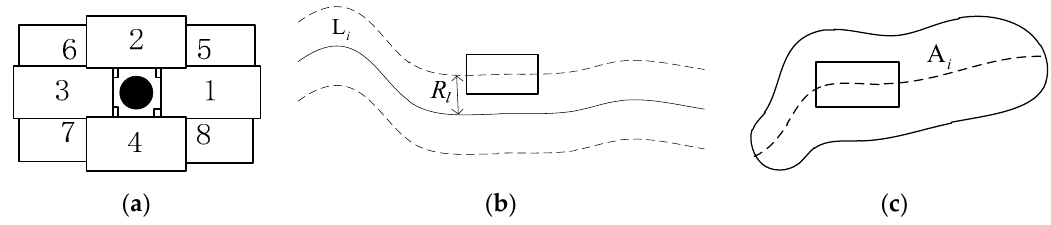
Figure 1. ( a ) A candidate-position model of a point feature; ( b ) a candidate-position model of a line feature; and ( c ) a candidate-position model of an area feature.